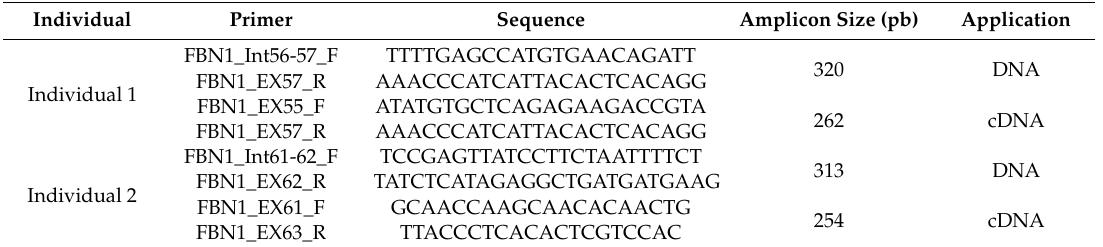
Table 1. Primers used for DNA amplification reverse transcription of FBN1 fragments carrying the investigated variants (RefSeq NM_000138) in individual 1 and individual